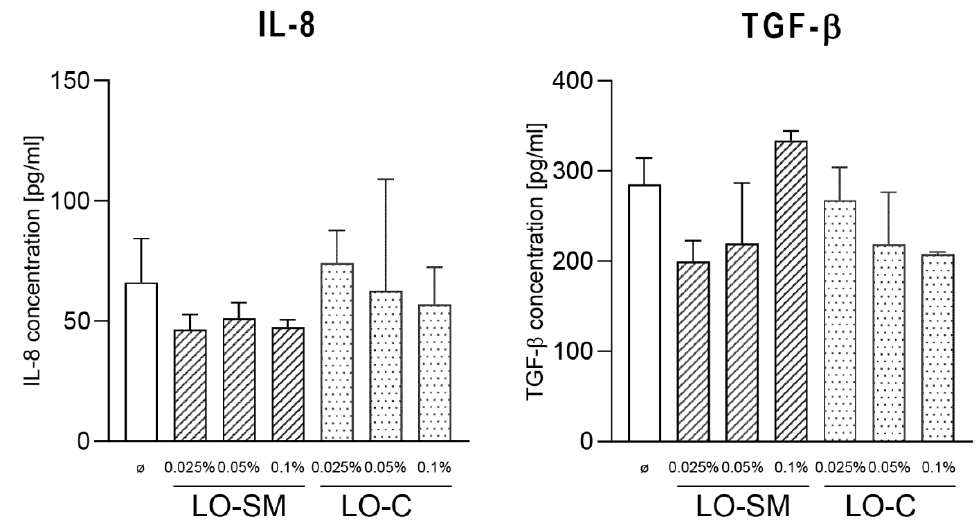
Figure 6. Effect of lavender oil stimulation on the cytokines production in human macrophages. hMDM cells were stimulated with designated concentrations ( v / v ) of commercial or in-house preparation of lavender oil for 24 h. Level of IL-6, TGF- β in cell media were verified with ELISA. Values are mean ± SD. Groups were compared to the control, and statistical analysis was performed using GraphPad Prism and build-in ANOVA test. p -values ≤ 0.05 were considered significant.